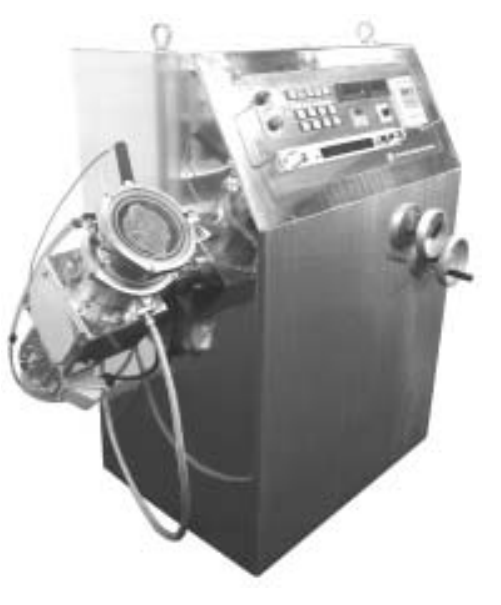
Lab-scale Nanocular for applying MechanoChemical Bonding (MCB) with the plasma assembly